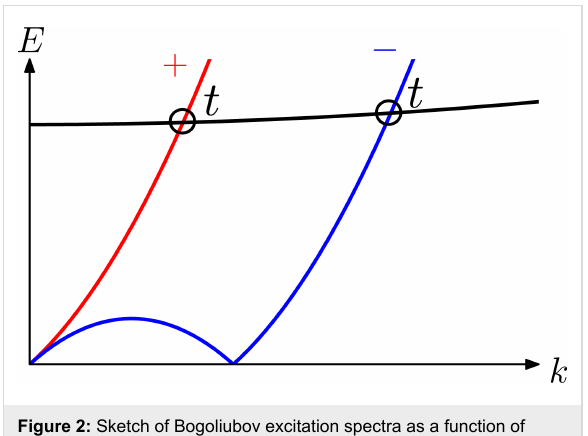
Figure 2: Sketch of Bogoliubov excitation spectra as a function of in the absence of tunneling, assuming and μ 2D = 0. The red and blue curves correspond to ± subbands of the 2DEG (Equation 7), respectively, which result from the spin-splitting Rashba SOI. The black curve corresponds to the lowest-energy subband of the superconductor (Equation 8). A weak tunneling ampli- tude t induces anticrossings in the spectrum where indicated and in- duces a superconducting gap in the 2DEG at the Fermi momenta (cor- responding to those momenta for which E ± ( k )=0). Due to the large energy mismatch between the superconducting subband and the Fermi points of the 2DEG, the induced gap is very